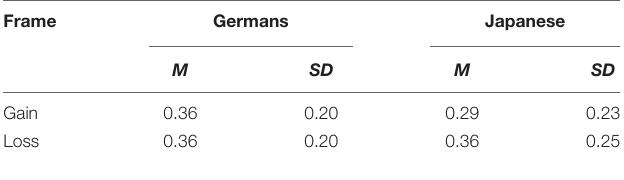
TABLE 3 | Mean ratings and standard deviations of the aspects of independence and interdependence in Germans and Japanese. Aspect